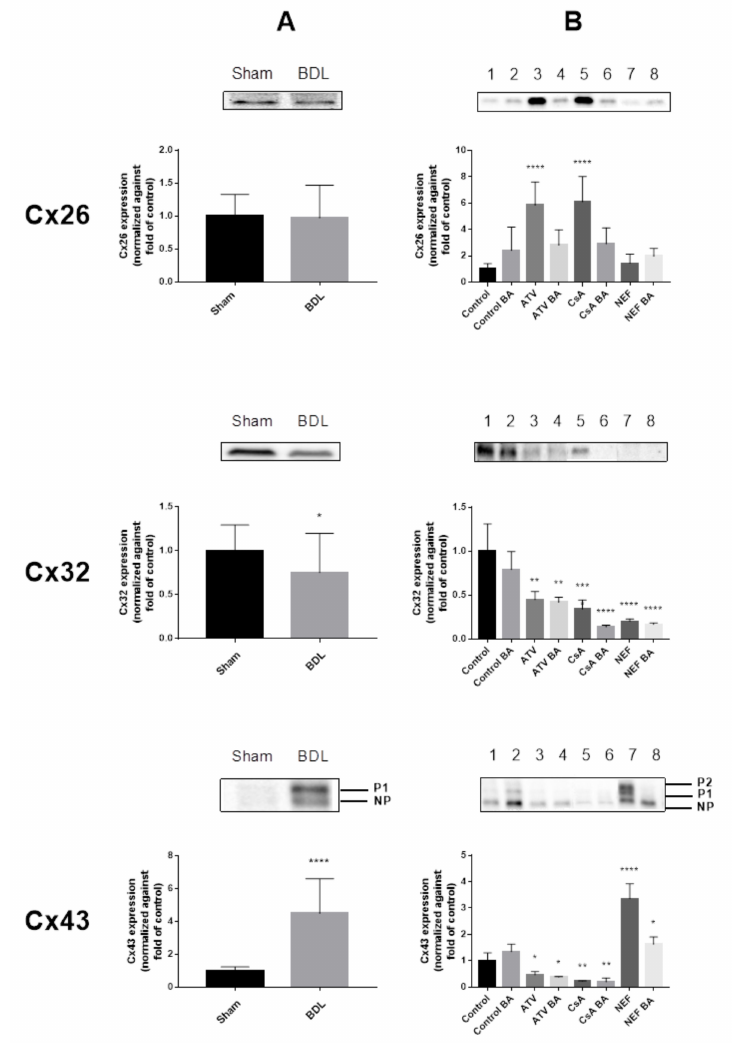
Figure 2. Connexin protein expression in cholestasis. Semi-quantitative immunoblot analysis of Cx26, Cx32 and Cx43 species in livers of cholestatic mice ( A ) and in human hepatoma HepaRG cells cultured in cholestatic conditions ( B ) was performed. For Cx43, both the phosphorylated (P) and non-phosphorylated (NP) variant could be detected. Signals of the three connexins were normalized against total protein loading and expressed as relative alterations compared to sham-operated animals or to control samples, respectively. ( A ) Liver sections were obtained from male mice following bile duct ligation (BDL) for 20 days. Data were processed by a parametric student t-test with Welch’s correction or a non-parametric Mann–Whitney test. Data are expressed as means +/ − SD with * p ≤ 0.05 and **** p ≤ 0.0001 compared to sham-operated animals (Sham n = 12; BDL n = 18) (N = 1). ( B ) Human hepatoma HepaRG cells were exposed to cholestatic drugs either in the absence or presence of a 50 × concentrated mixture of bile acids (BA) for 72 h and compared to untreated human hepatoma HepaRG cells, indicated in the figure as control. The di ff erent experimental conditions are presented in the figure as: 1 = control; 2 = control BA; 3 = atazanavir (ATV); 4 = ATV BA; 5 = cyclosporine A (CsA); 6 = CsA BA; 7 = nefazodone (NEF); 8 = NEF BA. Data were processed by a parametric one-way ANOVA followed by post hoc tests with Dunnett’s correction. Data are expressed as means +/ − SD with * p ≤ 0.05 ** p ≤ 0.01 *** p ≤ 0.001 and **** p ≤ 0.0001 compared to control samples (control n = 3; control BA n = 3; ATV n = 3; ATV BA n = 3; CsA n = 3; CsA BA n = 3; NEF n = 3; NEF BA n = 3) (N =